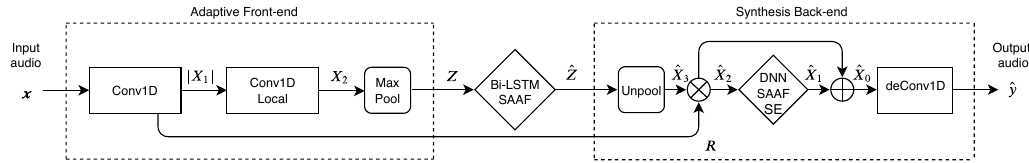
Figure 3. Block diagram of CRAFx ; adaptive front-end, latent-space Bi-LSTM and synthesis